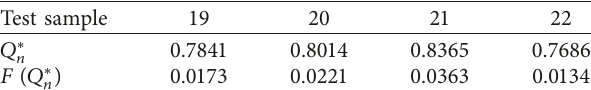
Table 4: Inspection for sample memory test.